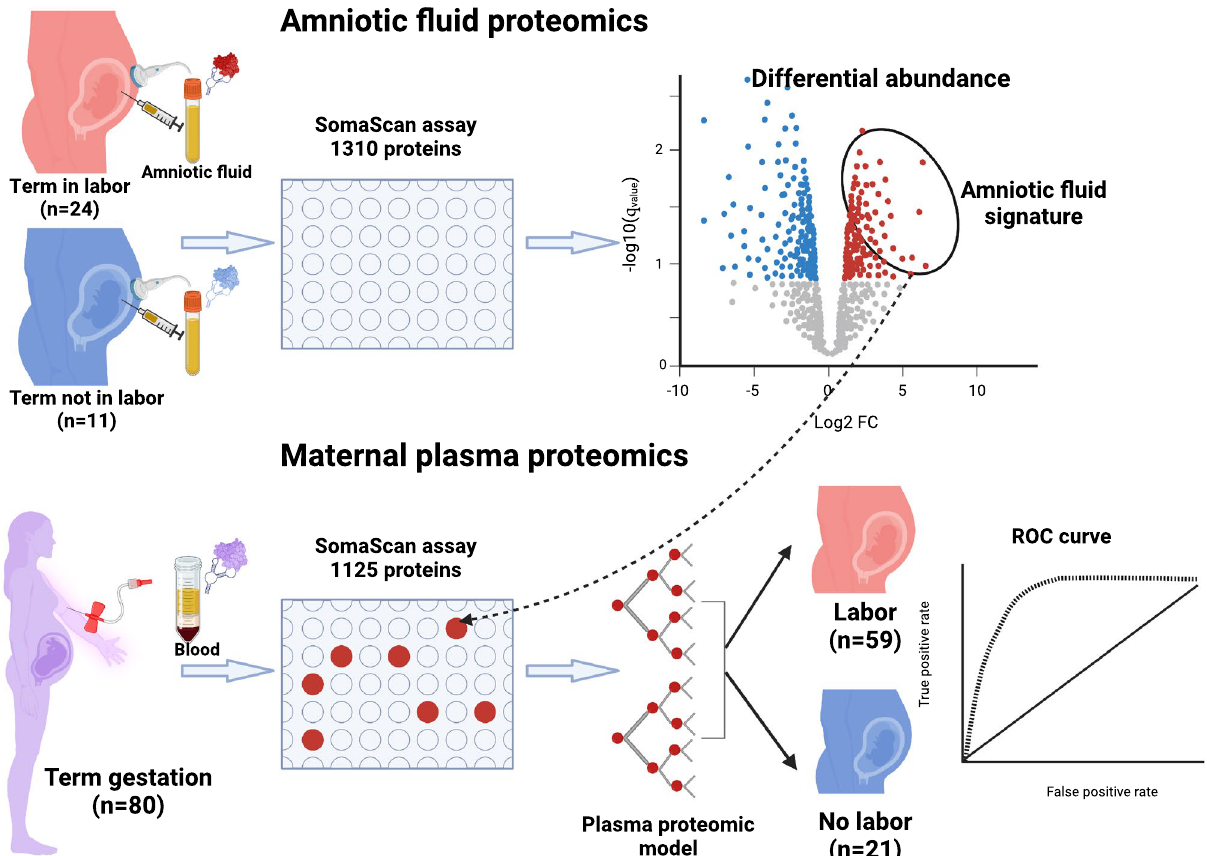
Figure 1. Study design and summary. The study included the determination of 1310 protein analytes in amniotic fluid samples collected at term from patients not in labor (TNL, n = 11) and from those in active labor (TIL, n = 24) (top panel). Maternal plasma concentrations of amniotic fluid proteins that significantly increased in abundance with labor were then used to discriminate labor from no labor groups in an independent set of pregnant women (TNL, n = 21 vs TIL, n = 59) (bottom panel). The figure was created with biorender.com 155 .